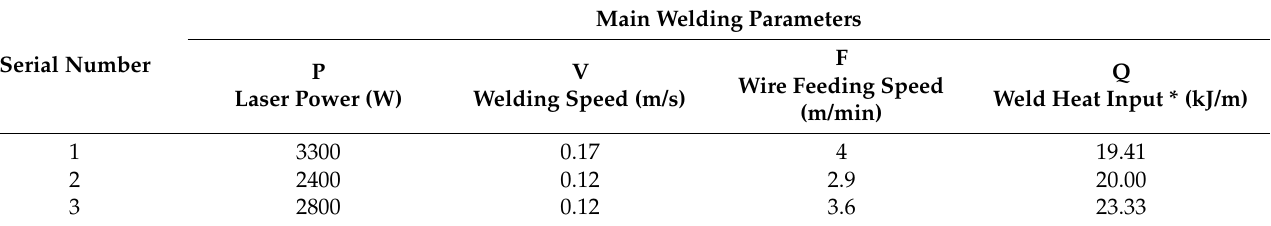
Table 2. Laser beam welding parameters of 2060T8/2099T83 aluminum–lithium alloys.